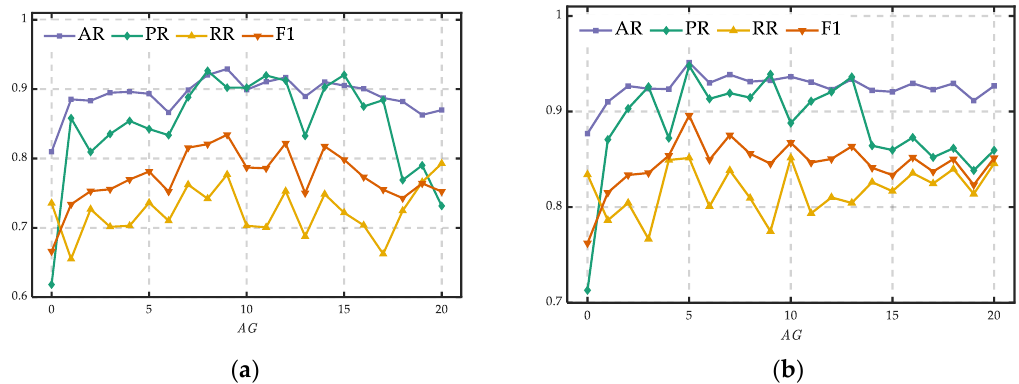
Figure 9. Performances of different AG . ( a ) Trends of indicators with a 50% training ratio; ( b ) trends of indicators with an 80% training ratio.